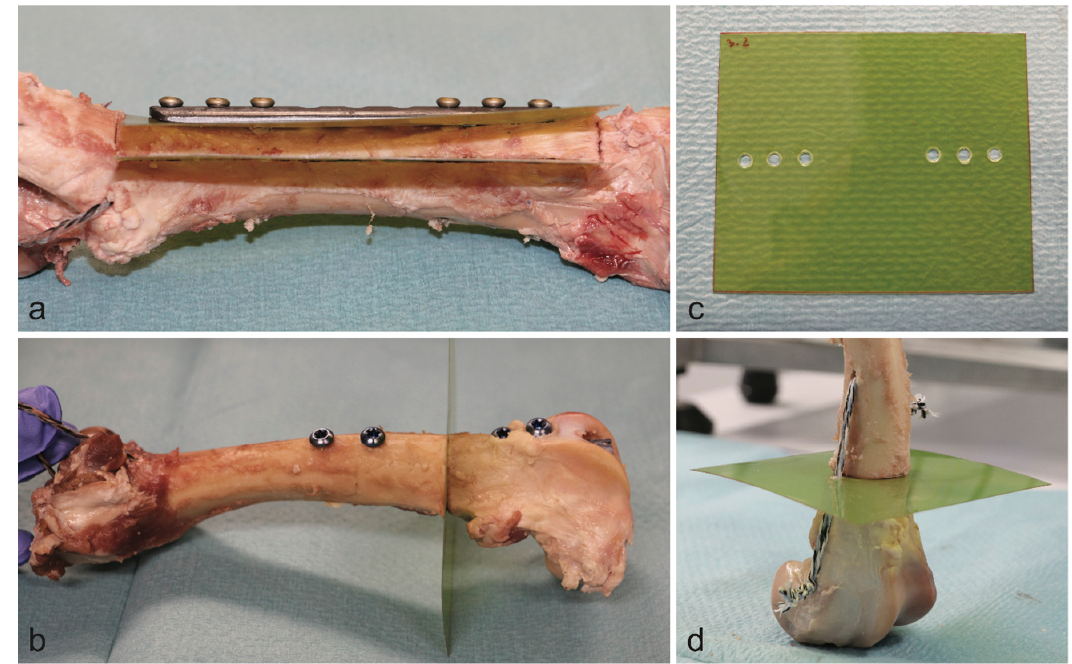
Figure 2. Position of dosimetry films in the plate model ( a ) and the intramedullary nail model ( b ). Dosimetry film with punch holes for the plate model ( c ). Reference bone of the nail model ( d ). The bones were placed within a cubic water basin. For the intramedullary nail setup, the radiation beam was oriented parallel to the dosimetry film and centered on the bone (Figure 3). The radiation beam was centered on the bone and between the two most central screws in the plate model. Each model was deployed with immersion depths of 5 and 10 cm for simulation of the upper and lower extremities, respectively.